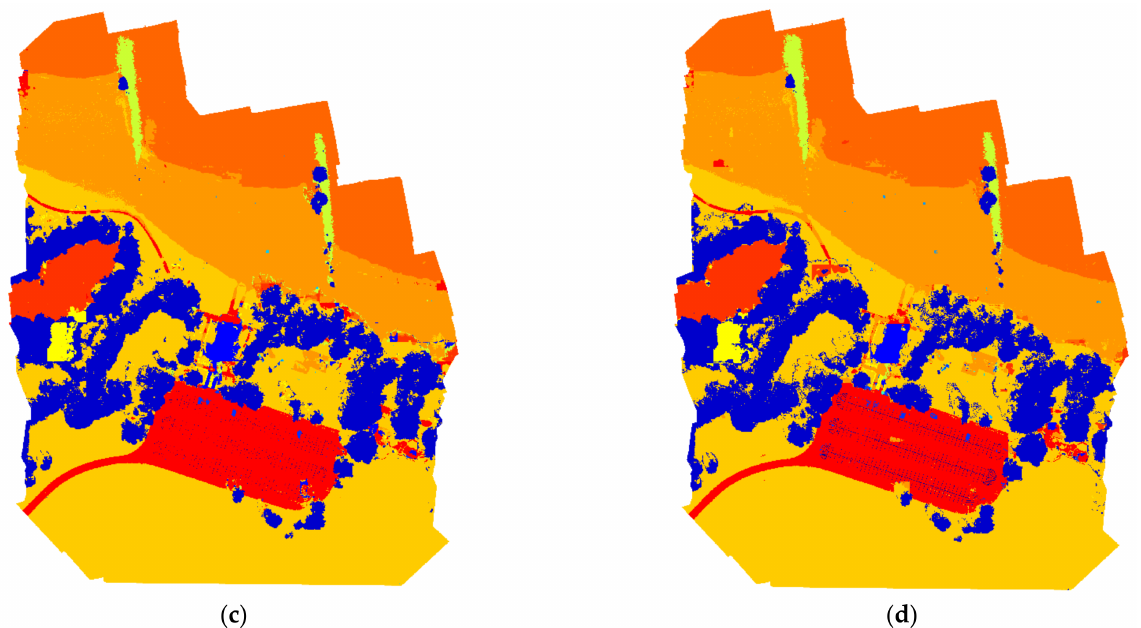
Figure 5. RIT-18 segmentation results for Swin-tiny on the test image: ( a ) ground truth, ( b ) segmenta- tion map using the DF approach, ( c ) segmentation map using the SGS approach, ( d ) segmentation map using LC-Net.